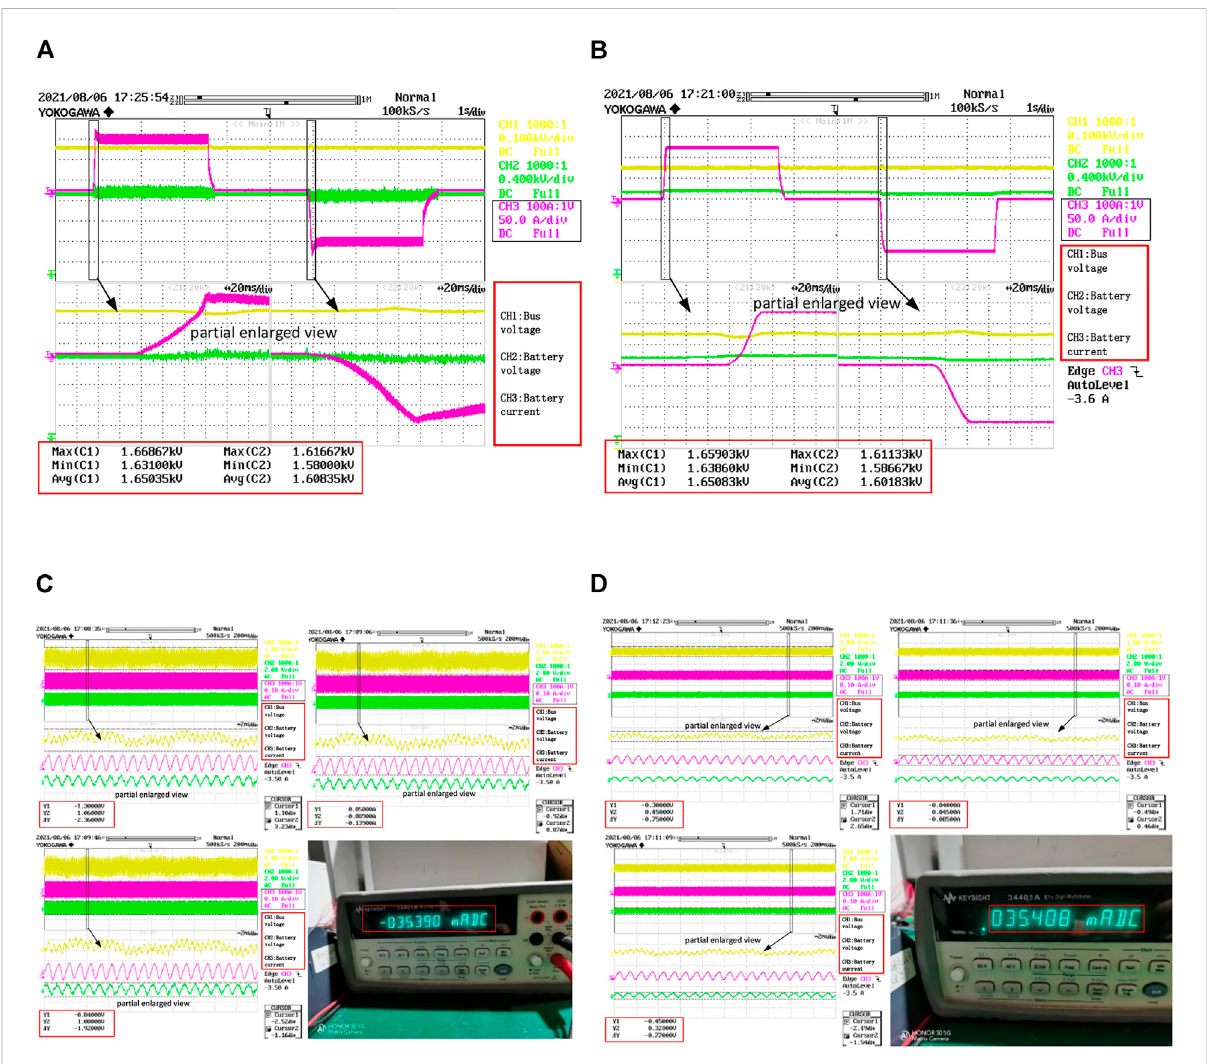
FIGURE 16 Experimental waveforms of output voltage, current, and bus during charging and discharging switching under symmetrical grid conditions ( (A, B) showsthetransientresponseundergridimbalanceinthetraditionaldoubleclosed-loopcontrolstrategyinFigures14andundergridnormalinthe controlstrategyproposedinthispaperinFigures16,respectively.and (C,D) showtheSteady-statecontrolaccuracyinthetraditionaldoubleclosed- loop control strategy and the control strategy proposed in this paper, respectively)..